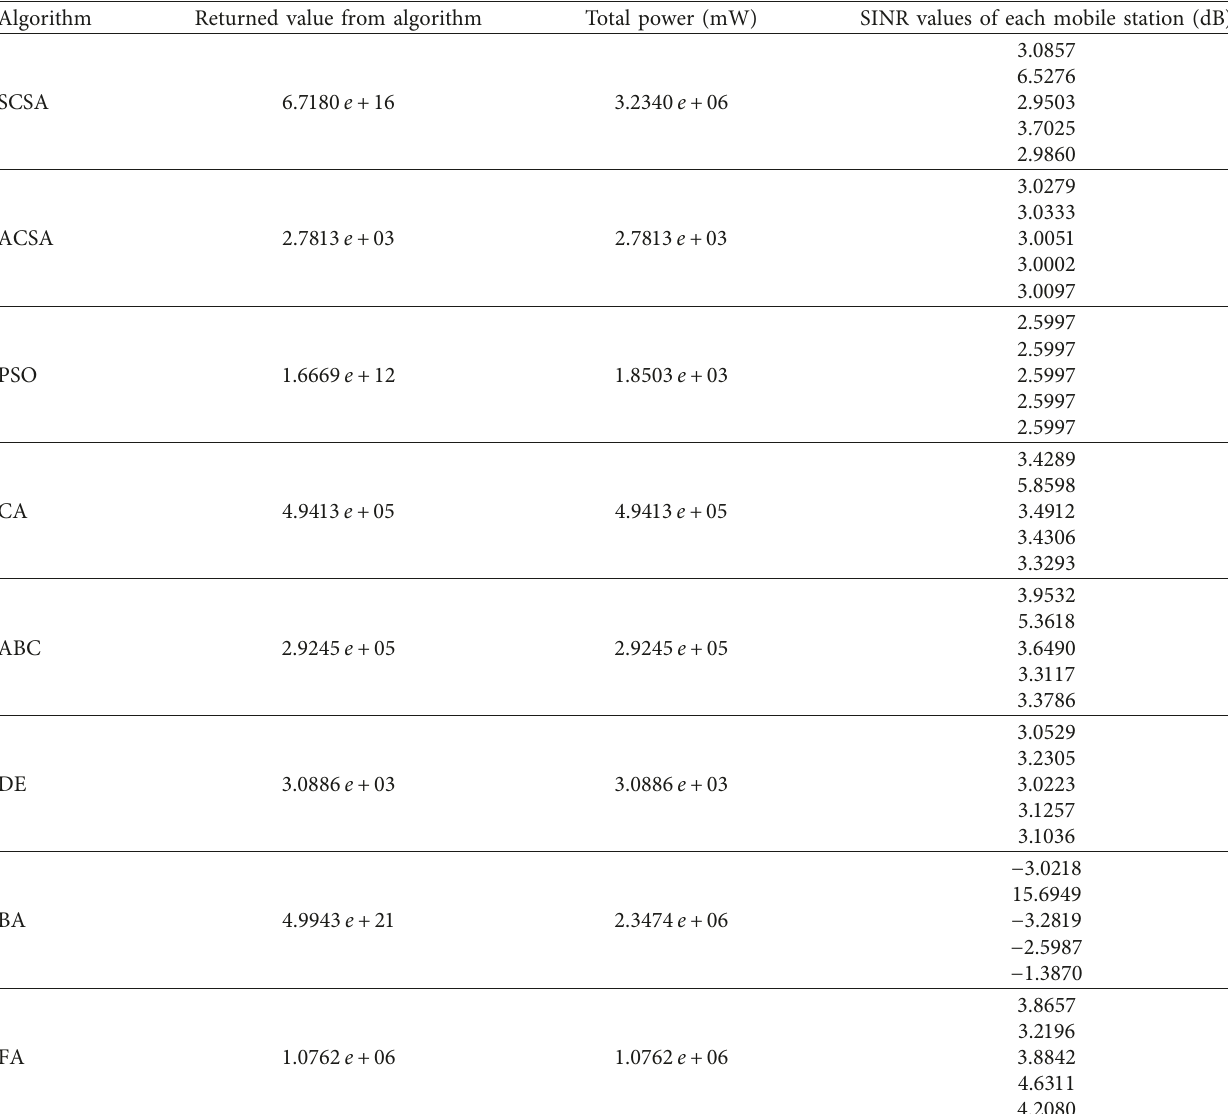
Figure 7: CDMA-based system with 4 users. Table 9: Returned results of ACSA and other standard optimization algorithms for scenario